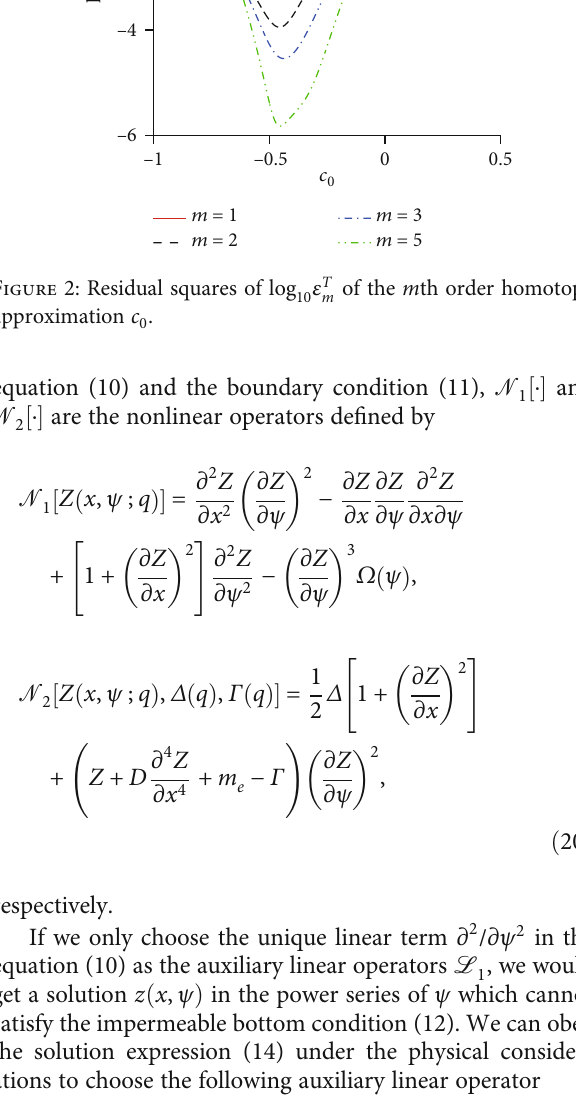
ε T of the m th order homotopy m 10